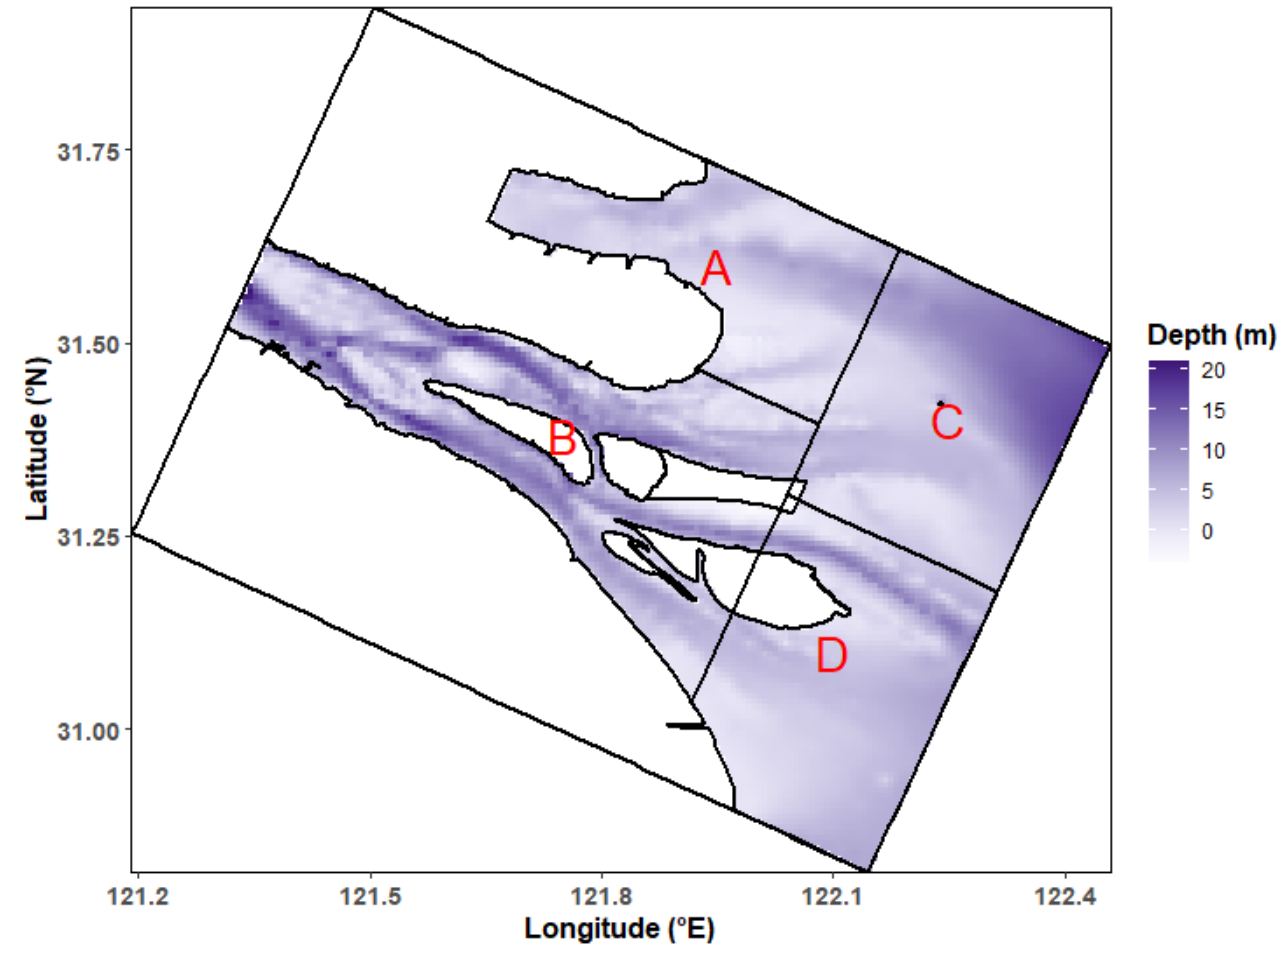
Figure 2. Stratified random sampling regions in the Yangtze Estuary.